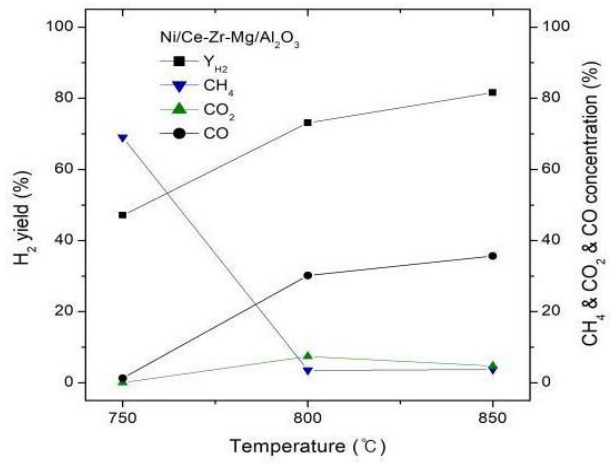
Figure 7. Effect of reaction temperature on hydrogen yield (S/C = 2, GHSV = 10,000h -1 ).